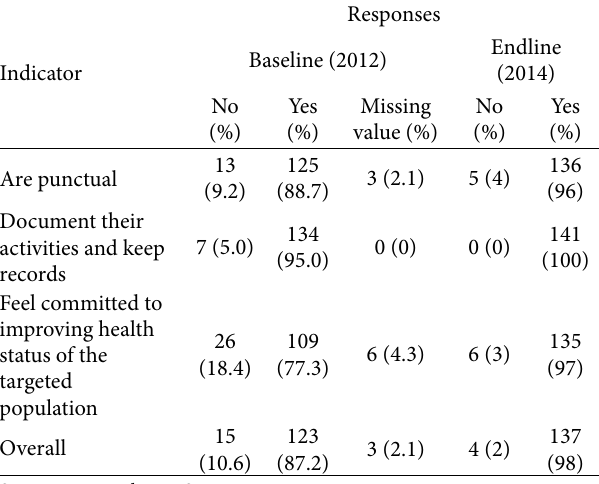
Table 5: Promotion of a sense of responsibility.